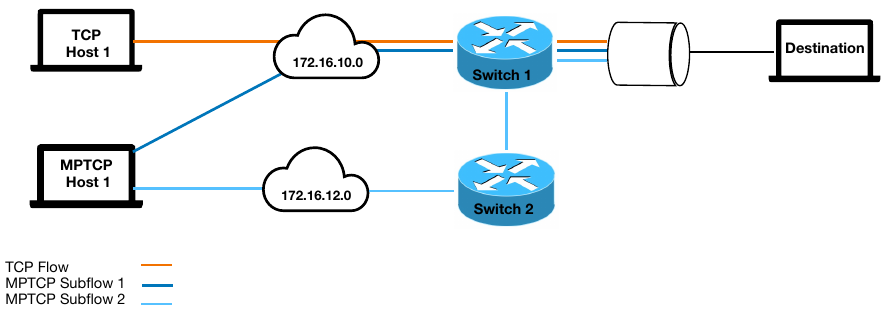
Figure 20. Experimental Topology for MPTCP Shared